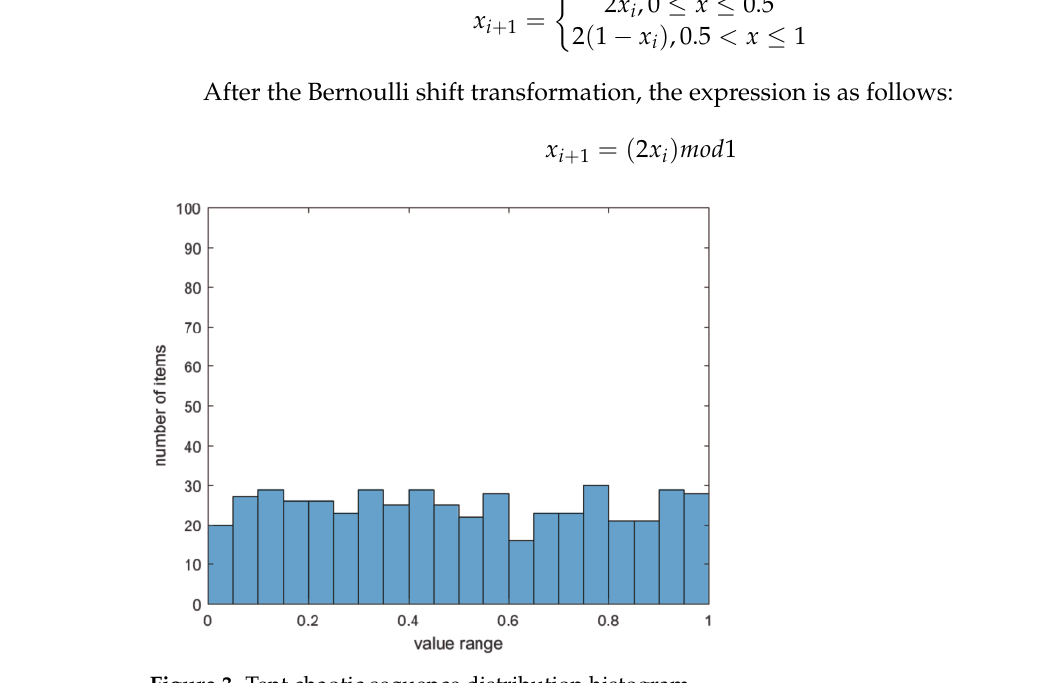
Figure 3. Tent chaotic sequence distribution histogram.